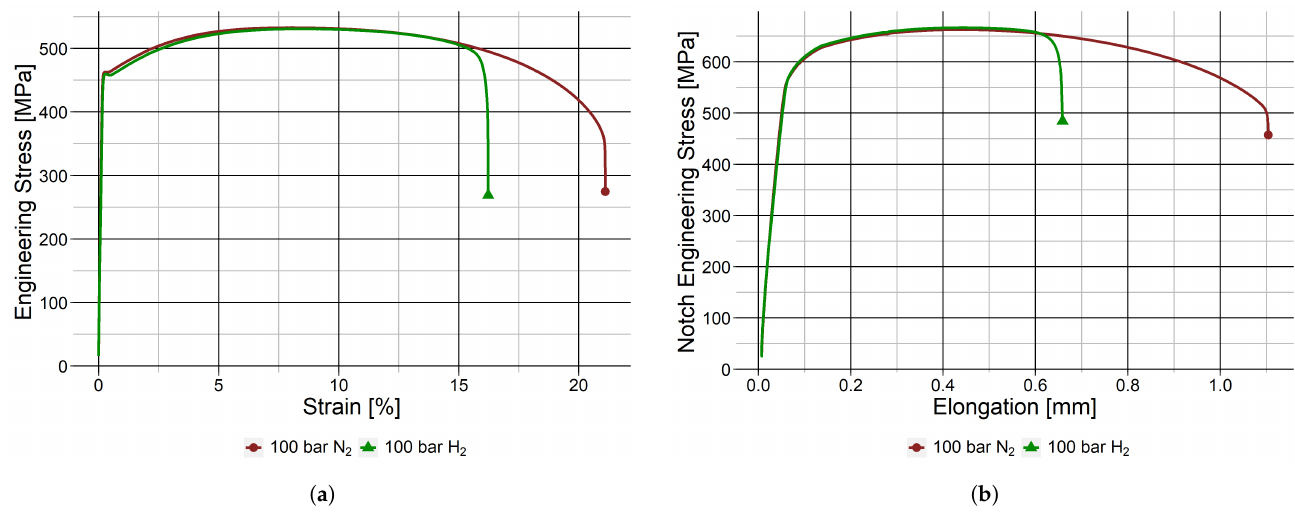
Figure 7. ( a ) SSRT results from representative samples of smooth base metal samples. ( b ) Results from representative samples of notched base metal